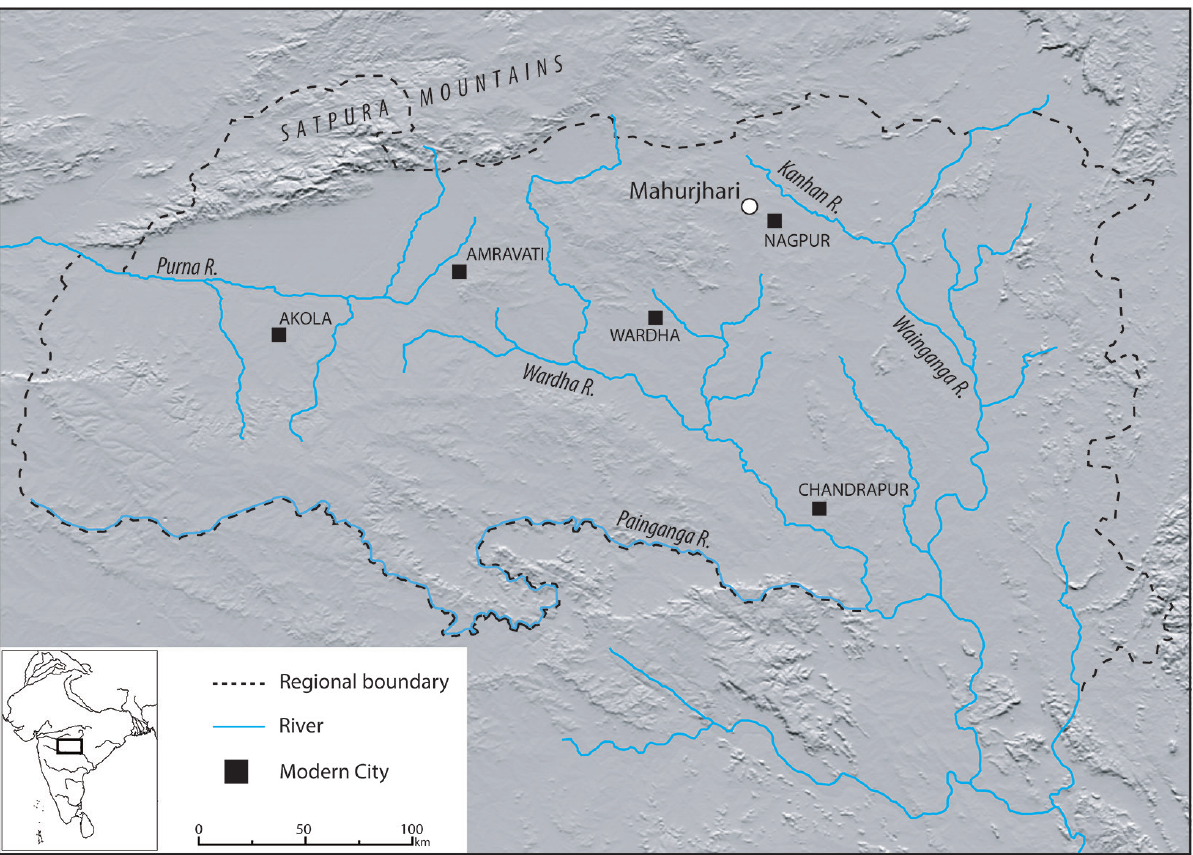
Figure 1: Map illustrating the geographical parameters of the Vidarbha region, and the location of modern cities for